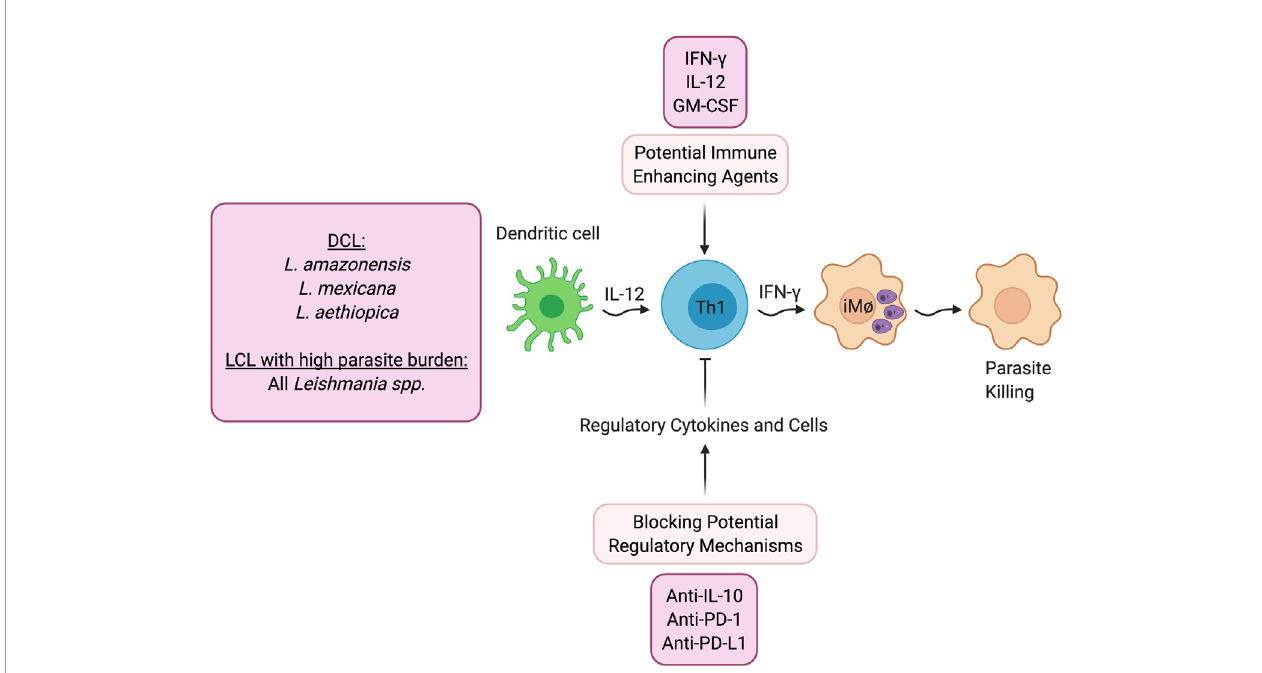
FIGURE 1 | Host directed therapies that promote better parasite control. DCL- Diffuse cutaneous leishmaniasis; LCL- Localized cutaneous